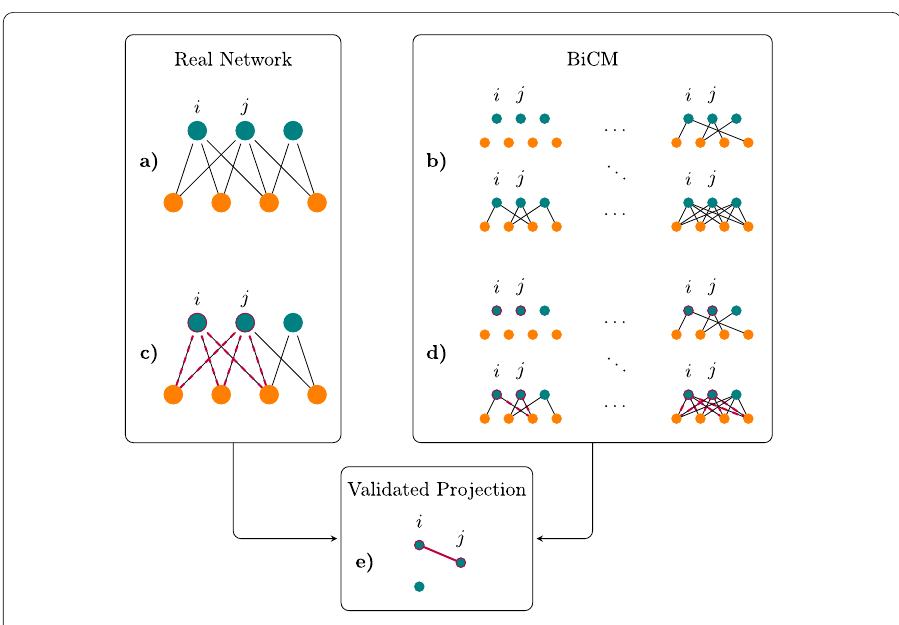
Figure 9 Schematicrepresentationofthevalidation/projectionproceduredescribedinSect. 3.3. ( a ) The validated projection procedure starts from a real bipartite network. The goal is to project the information contained in the system into the layer of turquoise nodes. ( b ) In order to compare the observations with a proper benchmark, we define the Bipartite Configuration Model (BiCM) ensemble. Such set includes all possible graphs, from the empty to the complete ones; in each realization, the number of nodes per layers is fixed to the value of the real network. ( c ) For the present example, we consider the couple ( i , j ) and count the number of common neighbours (the number of V-motifs ). We then compare the number of common neighbors in the real network with the one on the ensemble ( d ): if it is statistically significant with respect to the BiCM, ( e ) we have a link connecting i and j in the validated monopartite projection network. The figure is an adaptation from [18]